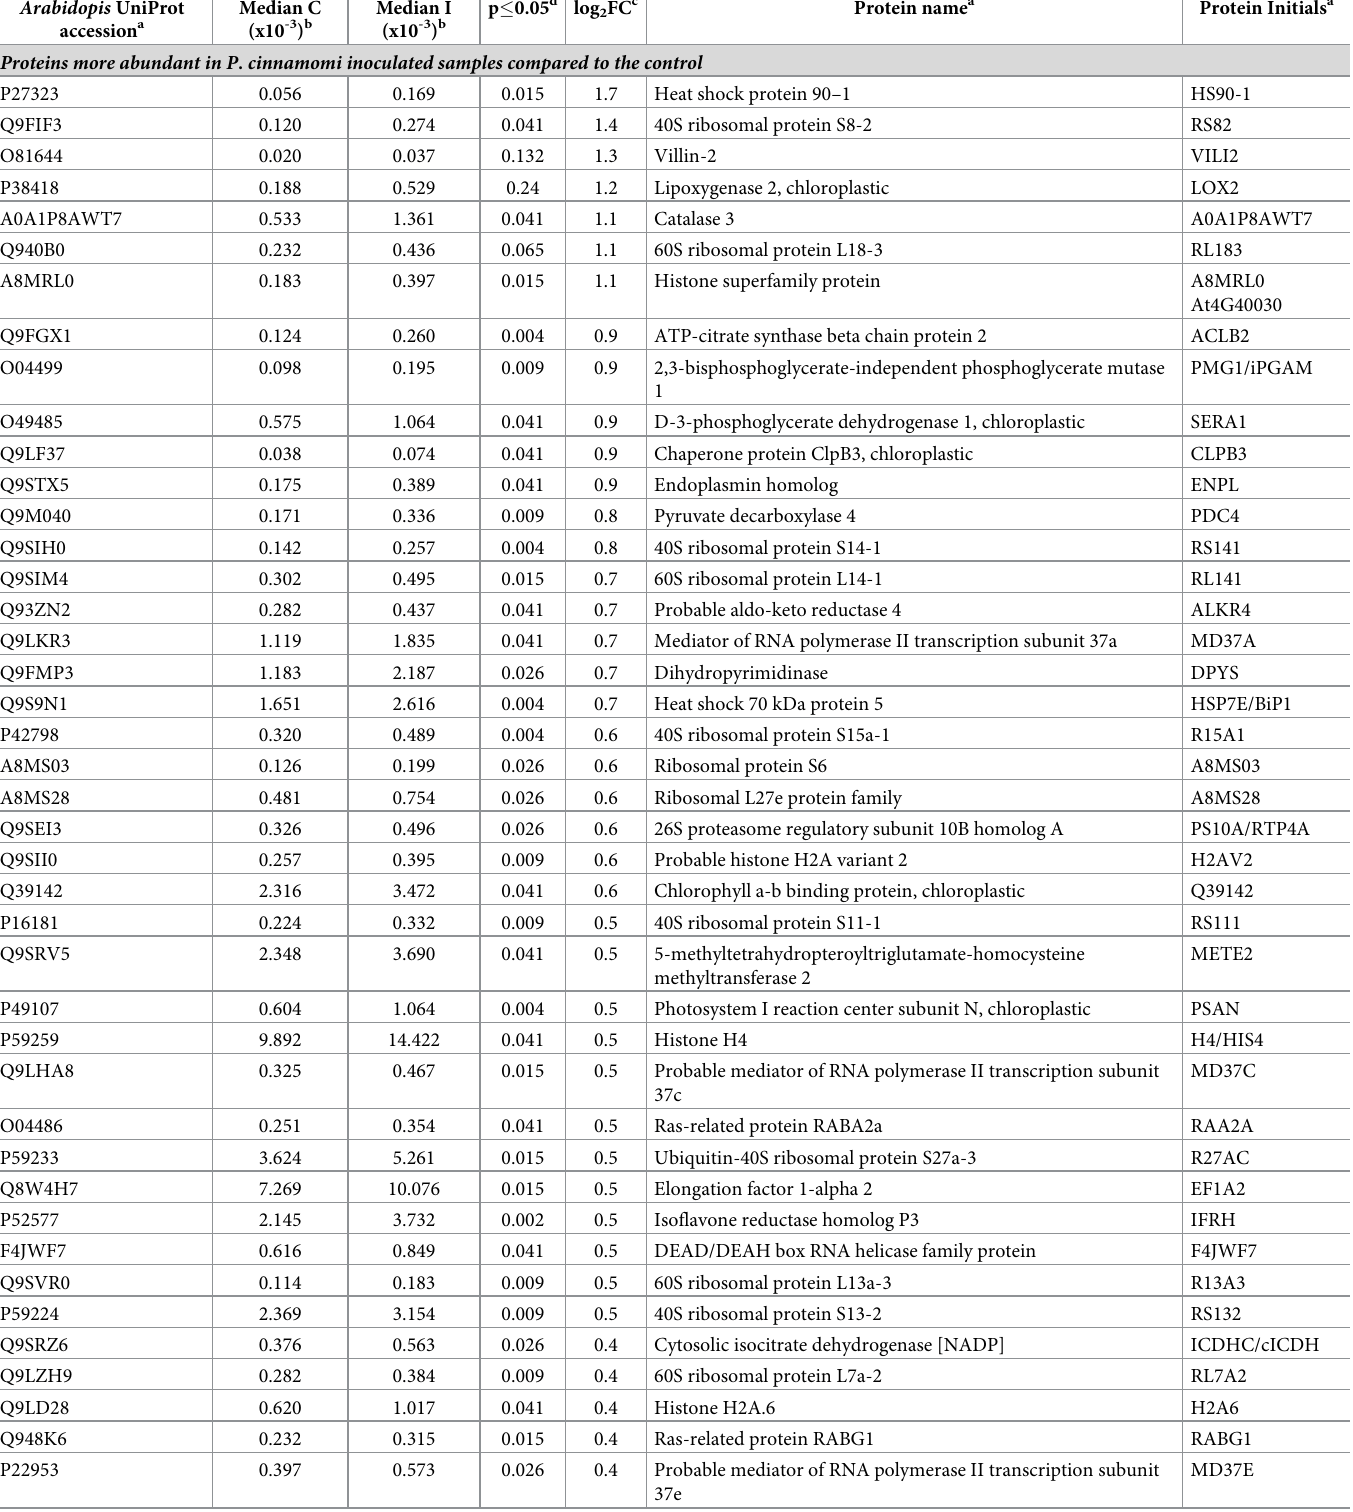
Table 2. List of differentially accumulated proteins in Q . suber leaf proteome 8 months after P . cinnamomi inoculation, using the Arabidopis proteome database as a reference. Arabidopis UniProt accession a Proteins more abundant in P . cinnamomi inoculated samples compared to the